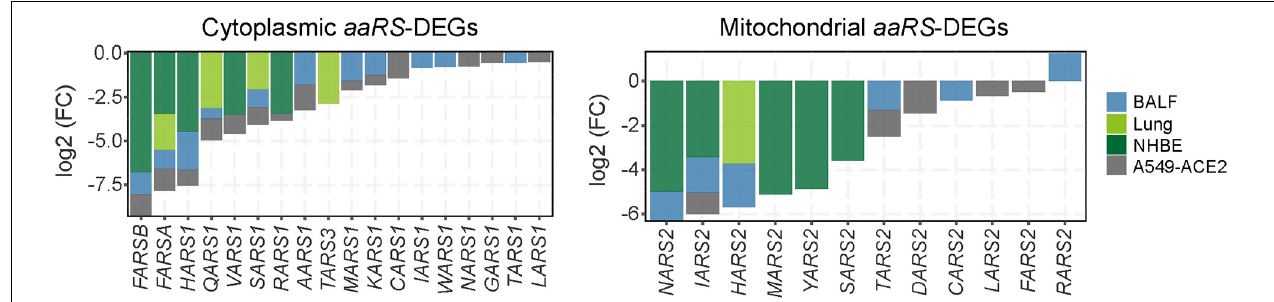
FIGURE 2 | Differentially expressed aminoacyl-tRNA synthetases (aaRSs) in patient-derived samples and cell lines infected with SARS-CoV-2. Transcription profile of aaRS -DEGs (with the cyto-aaRSs on the left and the mt-aaRSs on the right) in BALF, post-mortem lung tissues from coronavirus disease 2019 (COVID-19) patients, as well as in NHBE and A549-ACE2 cells infected with SARS-CoV-2.